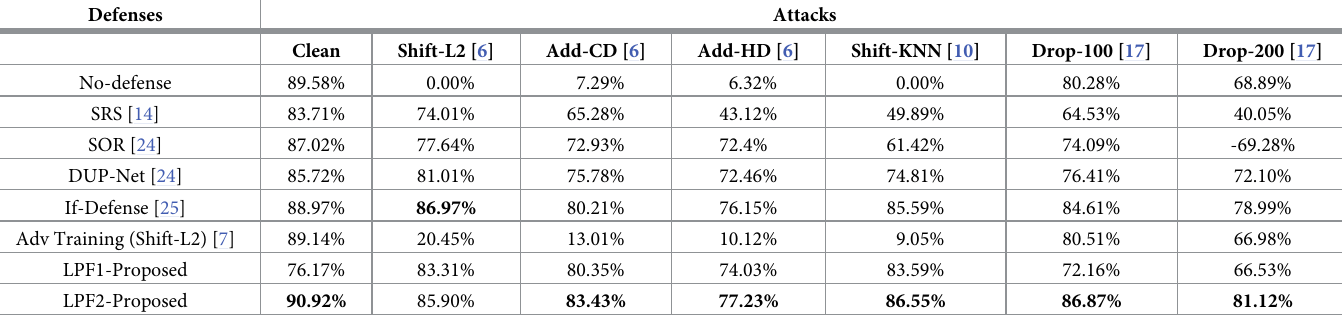
Table 2. Comparison of classification accuracy of proposed defenses with other defense strategies, under various attacks on PointNet++ and ModelNet40 datasets. Defenses Attacks Clean Shift-L2